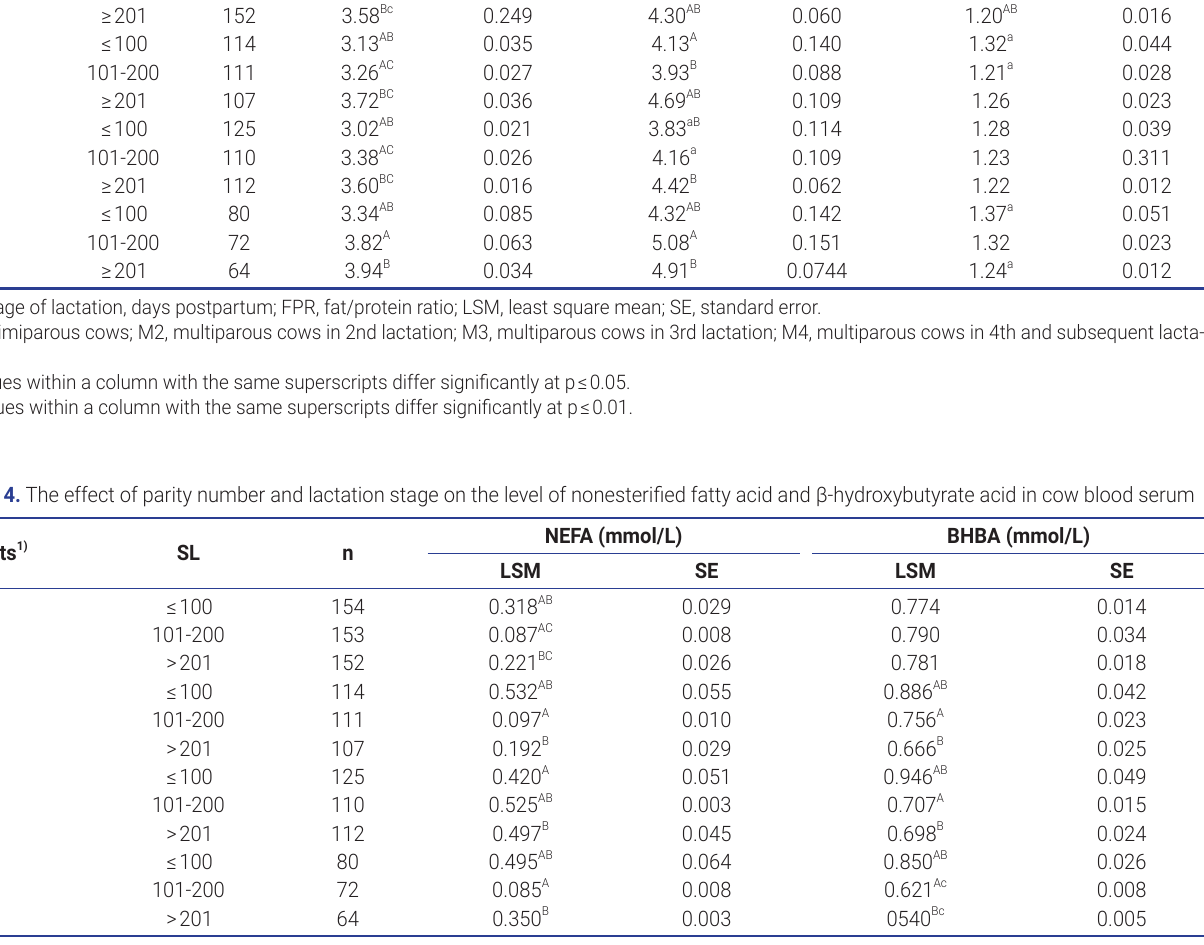
Table 3. The effect of lactation stage on the content of protein, fat and fat protein ratioin cow milk